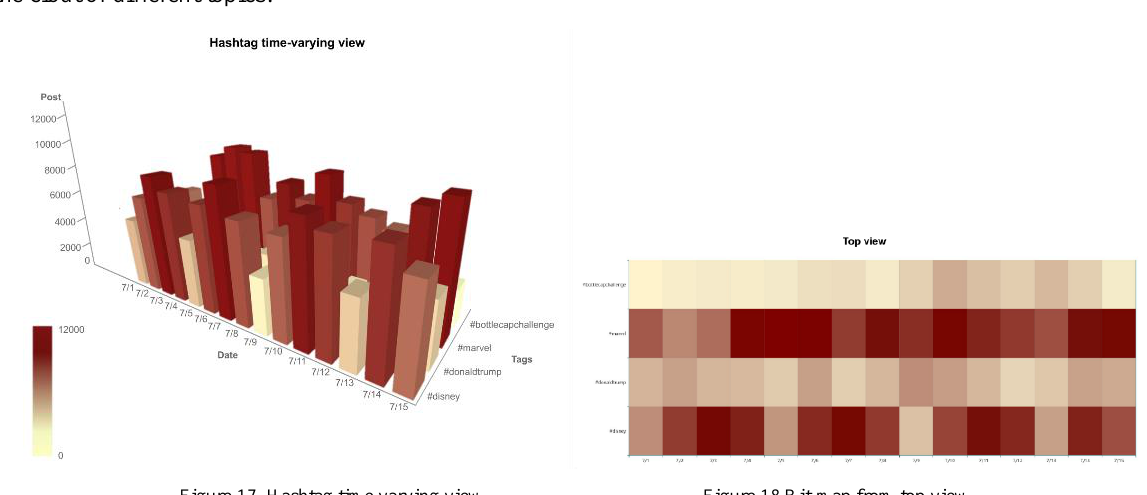
Figure 17 Hashtag time varying view Figure 18 Bit-map from top